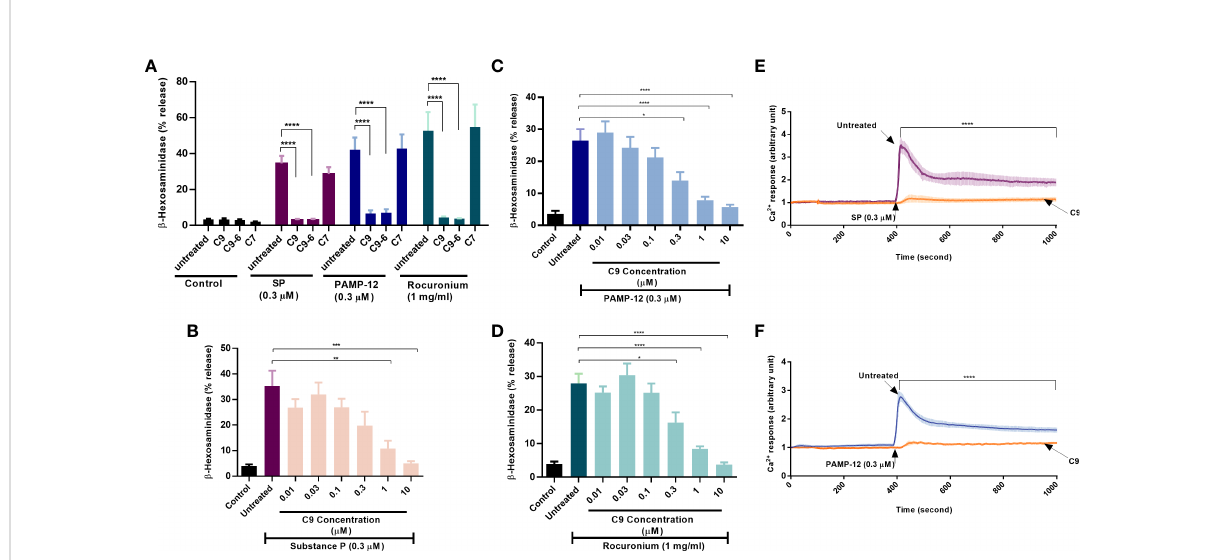
FIGURE 1 Compounds C9 and C9-6 inhibit substance P, PAMP-12, and rocuronium-induced degranulation and Ca 2+ mobilization in RBL-2H3 cells stably expressing MRGPRX2. (A) RBL-MRGPRX2 cells were preincubated with C9, C9-6, or C7 (10 µM, 5 min) before exposure to indicated concentrations of agonists for 30 min, and the degranulation was determined by quantitating b -hexosaminidase release. (B, C, D) RBL- MRGPRX2 cells were preincubated with different concentrations of C9 (5 min) followed by agonist stimulation and b -hexosaminidase release was measured. (E,F) Cells were preincubated with C9 (DMSO for control) and Ca 2+ mobilization was determined following stimulation with SP or PAMP-12 (0.3 µM, 10 min). Data are the mean ± SEM of at least three experiments. Statistical signi fi cance was determined using one-way ANOVA test at a value * P < 0.05, ** P < 0.01, *** P < 0.001 and **** P <